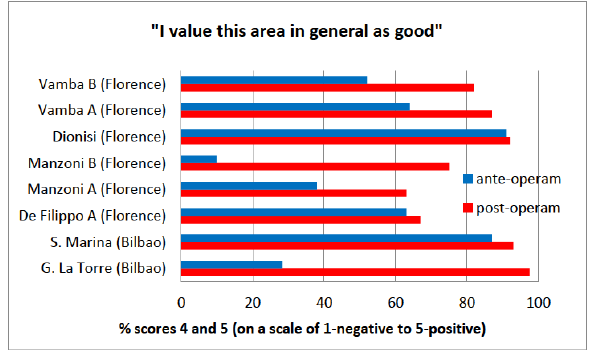
Chart 2: Citizens perception immediately after the interventions realization in Florence (for each area the letter A or B refers to the identified HUAs) and